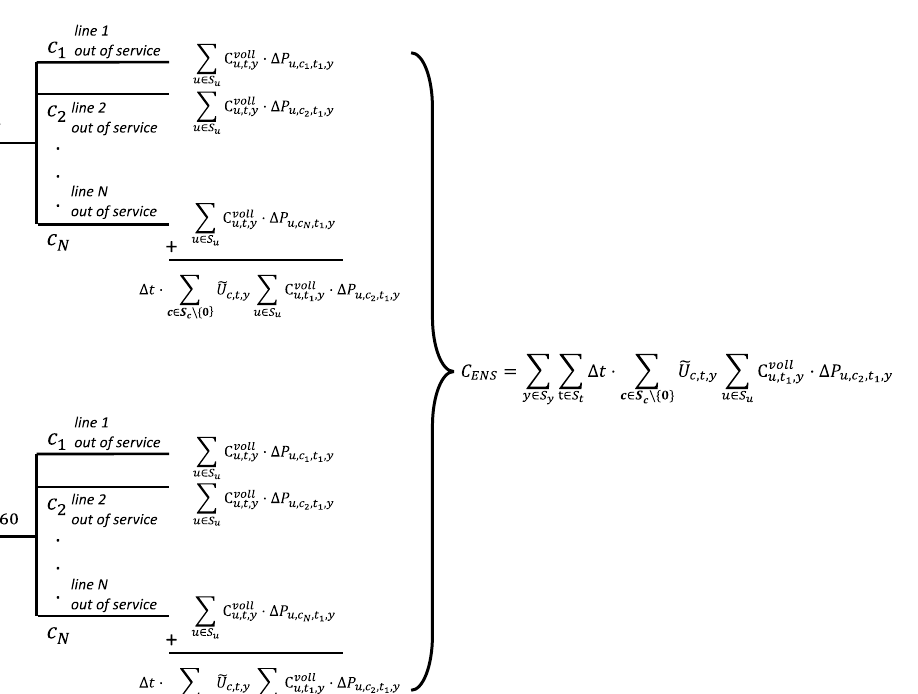
Figure 3. Schematic view of the results of the Monte Carlo scenario generation [15].